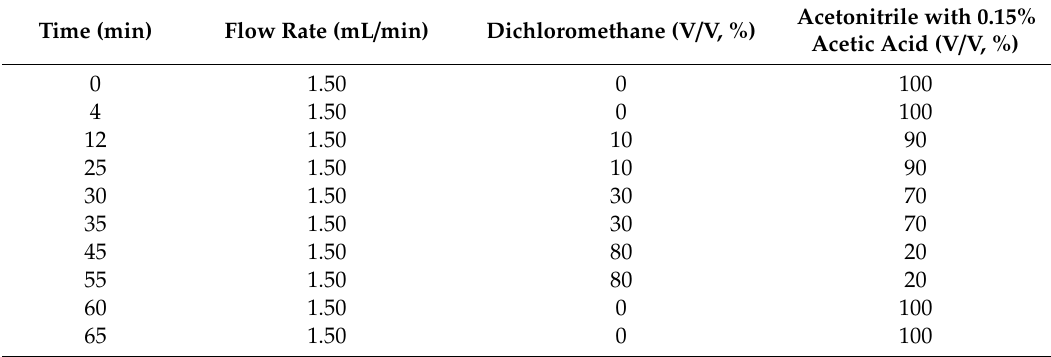
Table 1. Gradient elution